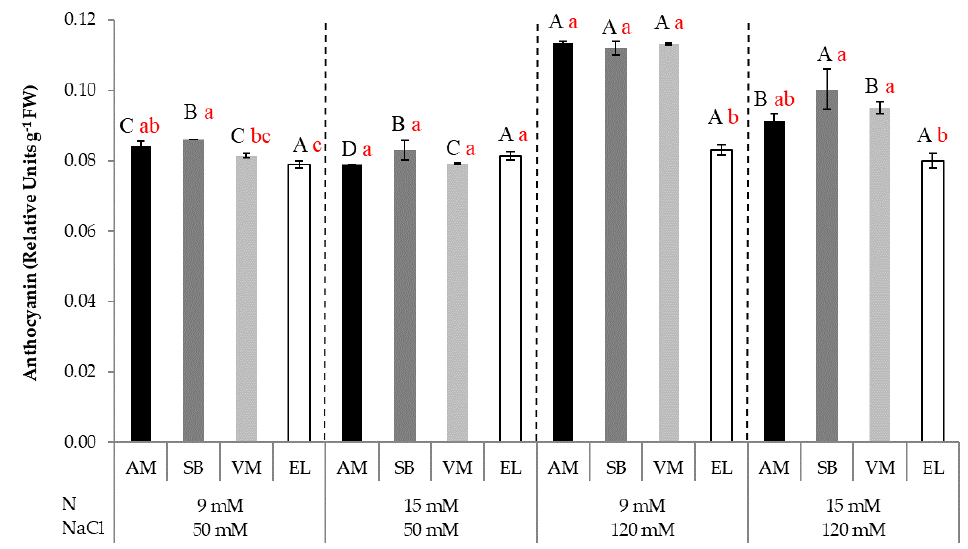
Figure 6. Anthocyanin contents in Arthrocnemum macrostachyum (AM), Salicornia brachiata (SB), and Sarcocornia fruticosa ecotypes (EL and VM). LN under different combinations of N (9 and 15 mM) and NaCl (50 and 120 mM). Means plus standard errors ( ± SE) are shown. Different uppercase letters show significant differences between treatments of one ecotype (same color bars), and different lowercase red letters show significant differences between ecotypes within the same treatment (Tukey’s HSD, p ≤ 0.05, n = 2–3).